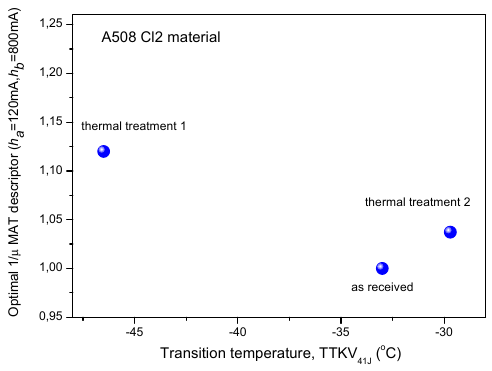
Figure 8. Optimally chosen normalized MAT descriptor as a function of transition temperature for A508 Cl2